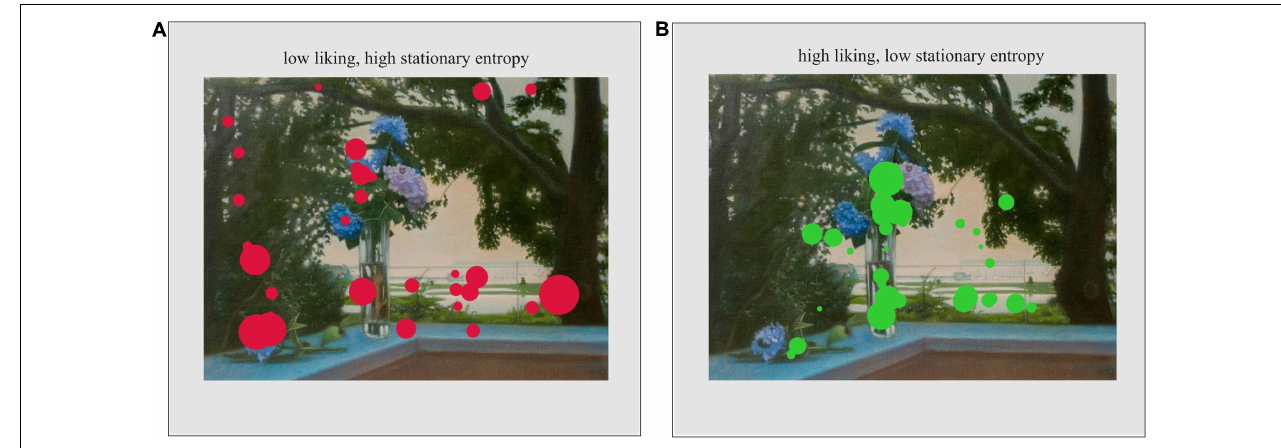
FIGURE 6 | Examples of fixation distributions from selected participants for a disliked image with high stationary entropy of fixations (A) , and a liked image with low stationary entropy of fixations (B) . The circles represent fixations and their size represents relative fixation duration.